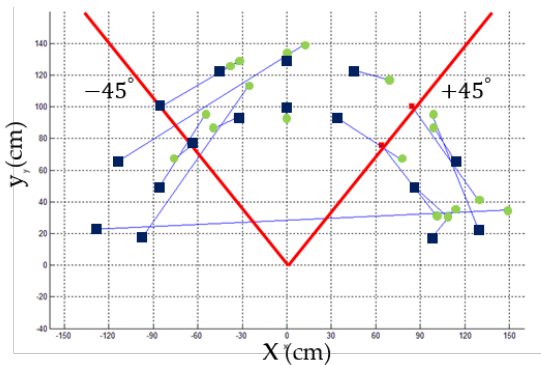
Figure 11. Experiment result in searching for a reliable region.